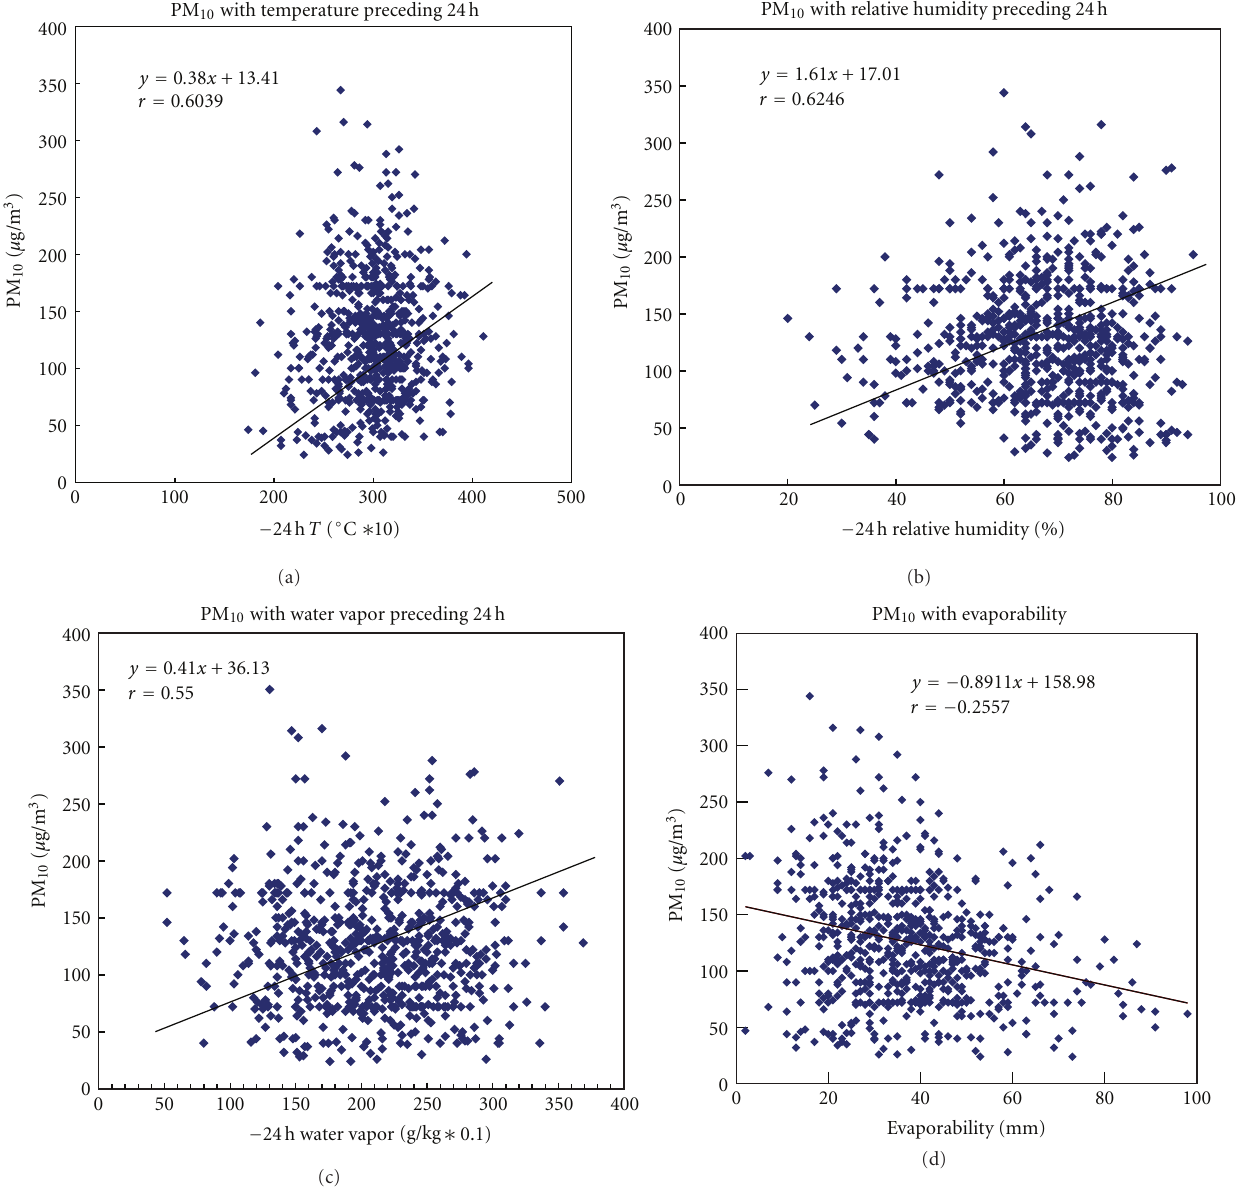
Figure 1: Correlation of PM 10 with temperature (a), relative humidity (b), water vapor observed (c), and evaporability (d) preceding 24h.